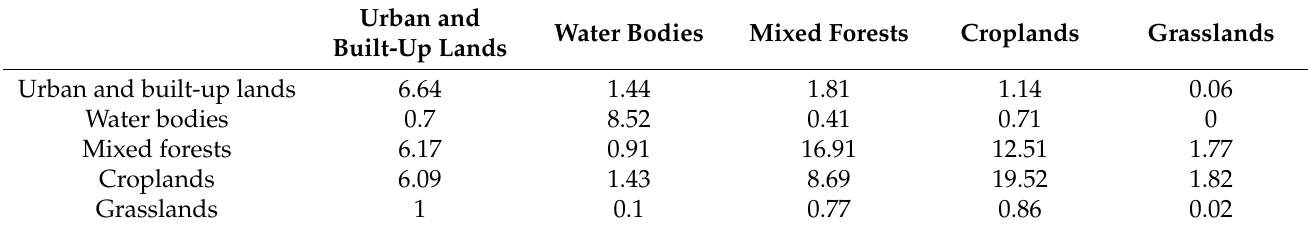
Table A2. The transition matrix of land use/land cover classification for Z01 from 1985 to 2000 (%).